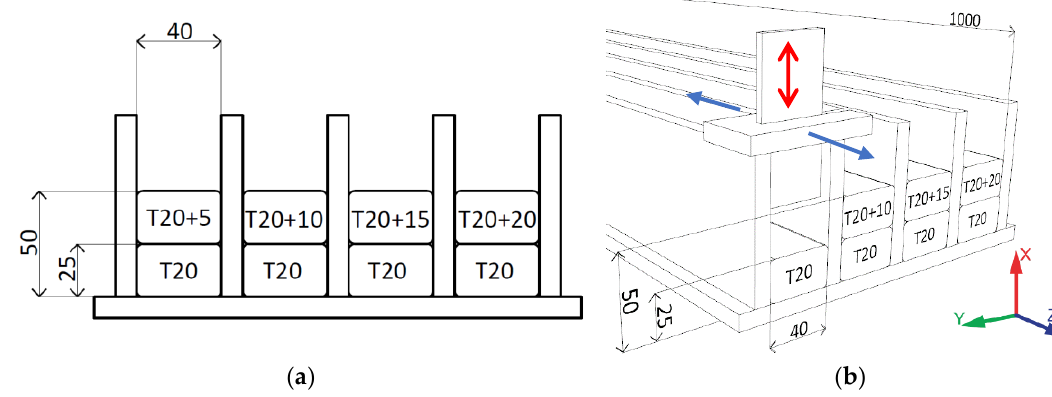
Figure 2. ( a ) Schema represents the layer deposition time intervals, dimension units in millimeters; ( b ) schema of the forms and the adjustable trowel, dimension units in millimeters.